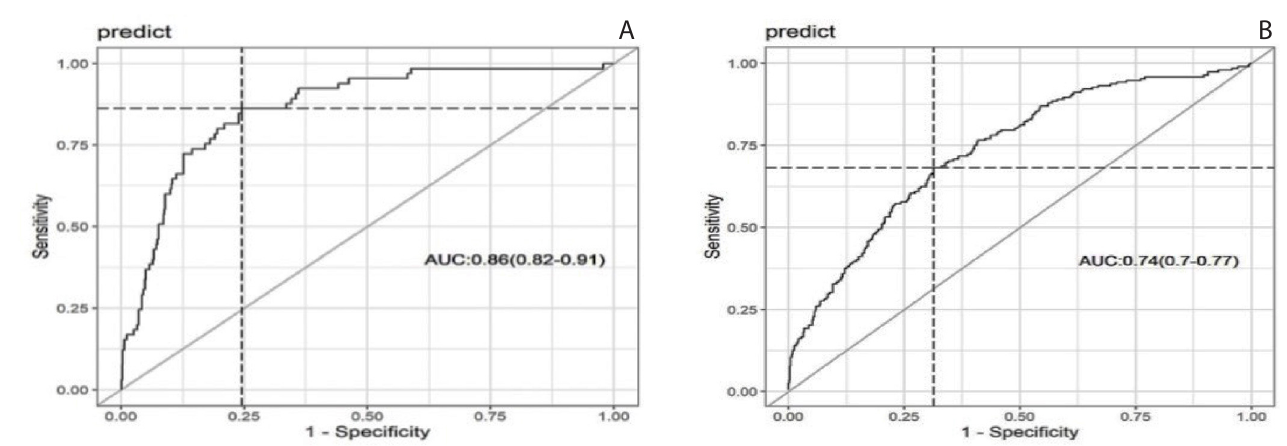
Fig. 2 - Multivariate model analysis through the receiver operating characteristic (ROC) curve. A) Mortality multivariate model analysis through the ROC curve. B) Complications multivariate model analysis through the ROC curve. AUC=area under the curve.